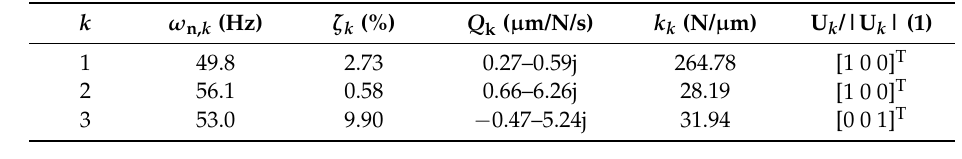
Table 6. Modal parameters at L = 610 mm ram overhang.